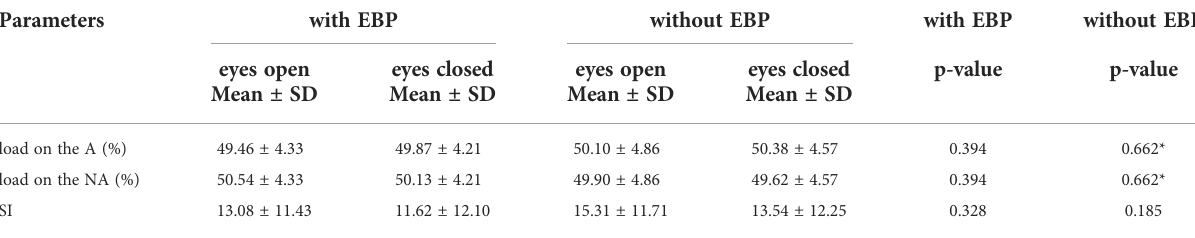
TABLE 5 Comparison of the weight-bearing distribution between the A and NA sides during the test with eyes open and closed while standing alone with and without the EBP (N = 52). Parameters